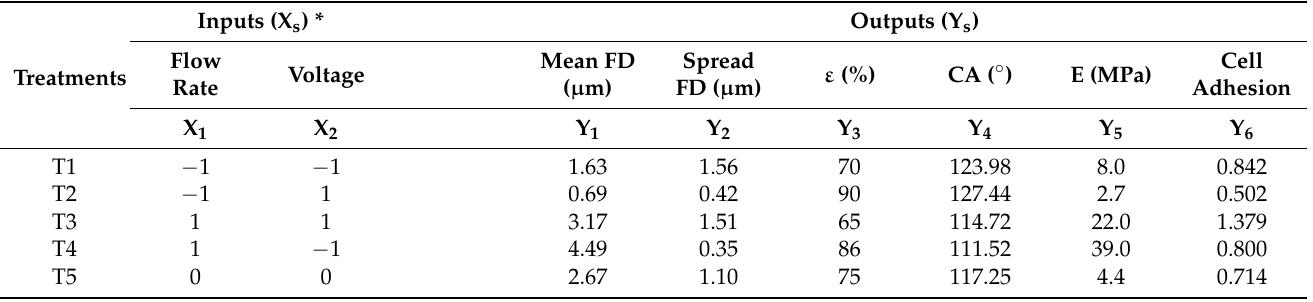
Table 4. Summary experimental matrix with input and output data from the DOE analysis.